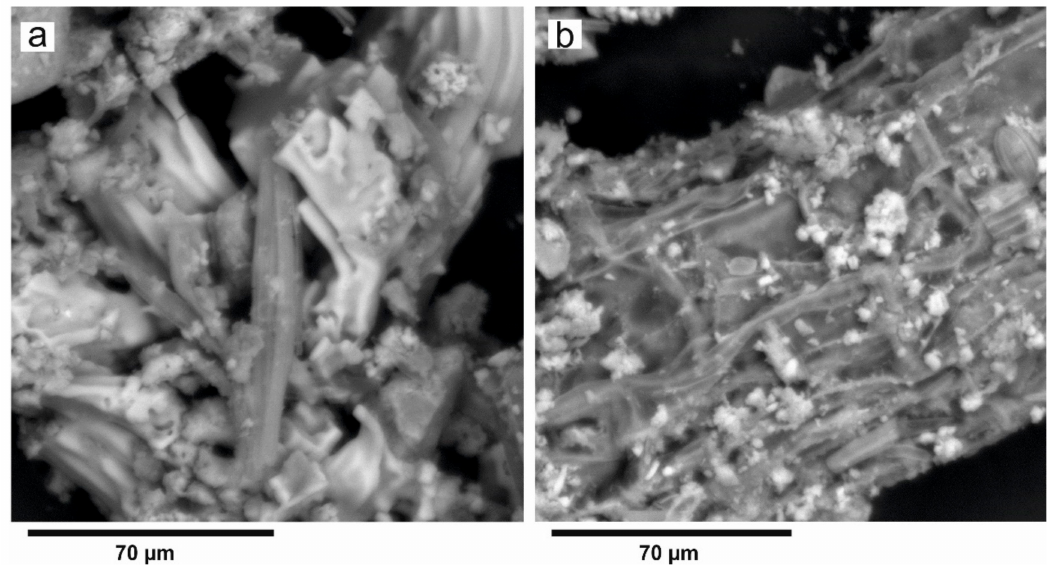
Figure 13. Lower soil horizon (3–15 cm depth) black gel-like phases, hydrotroillite horizon: ( a ) siliceous remains of diatoms, halite, iron-bearing formation; ( b ) plant residue covered by siliceous remains of diatoms and iron-bearing